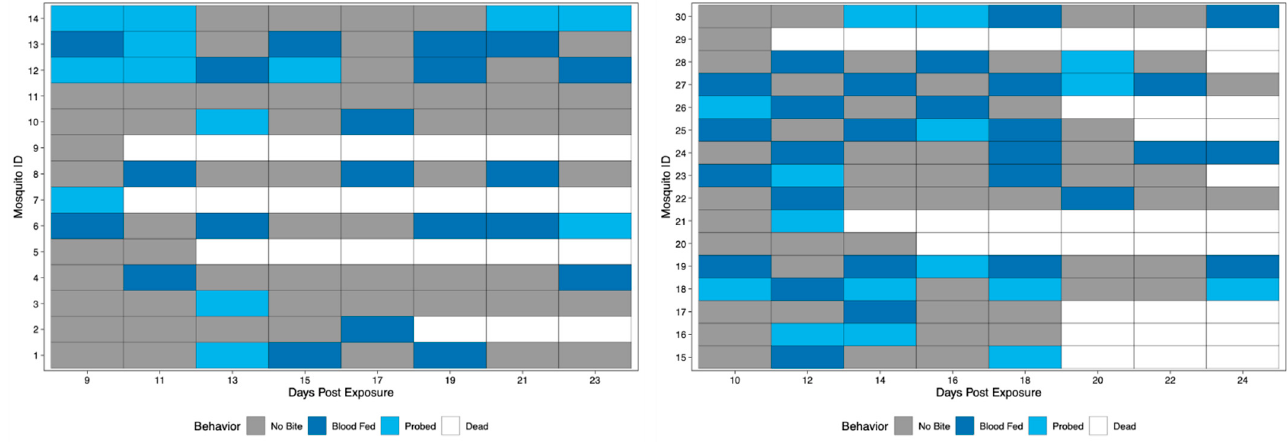
Figure 5. Biting behavior of field-derived individuals over the study period. Each row represents one mosquito across days post exposure. Each shaded square represents a potential transmission event, with mosquitoes being classified as no biting (grey), probing (light blue), and blood fed (dark blue). White squares indicate no opportunity (dead). Mosquito IDs 1–14 represent Group 1 (left), while IDs 15–30 represent Group 2 (right).